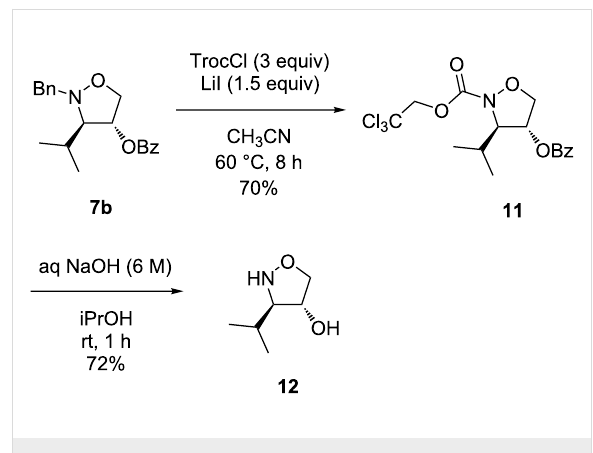
The C-3/4- cis isoxazolidin-4-ols 10b and 10c were obtained